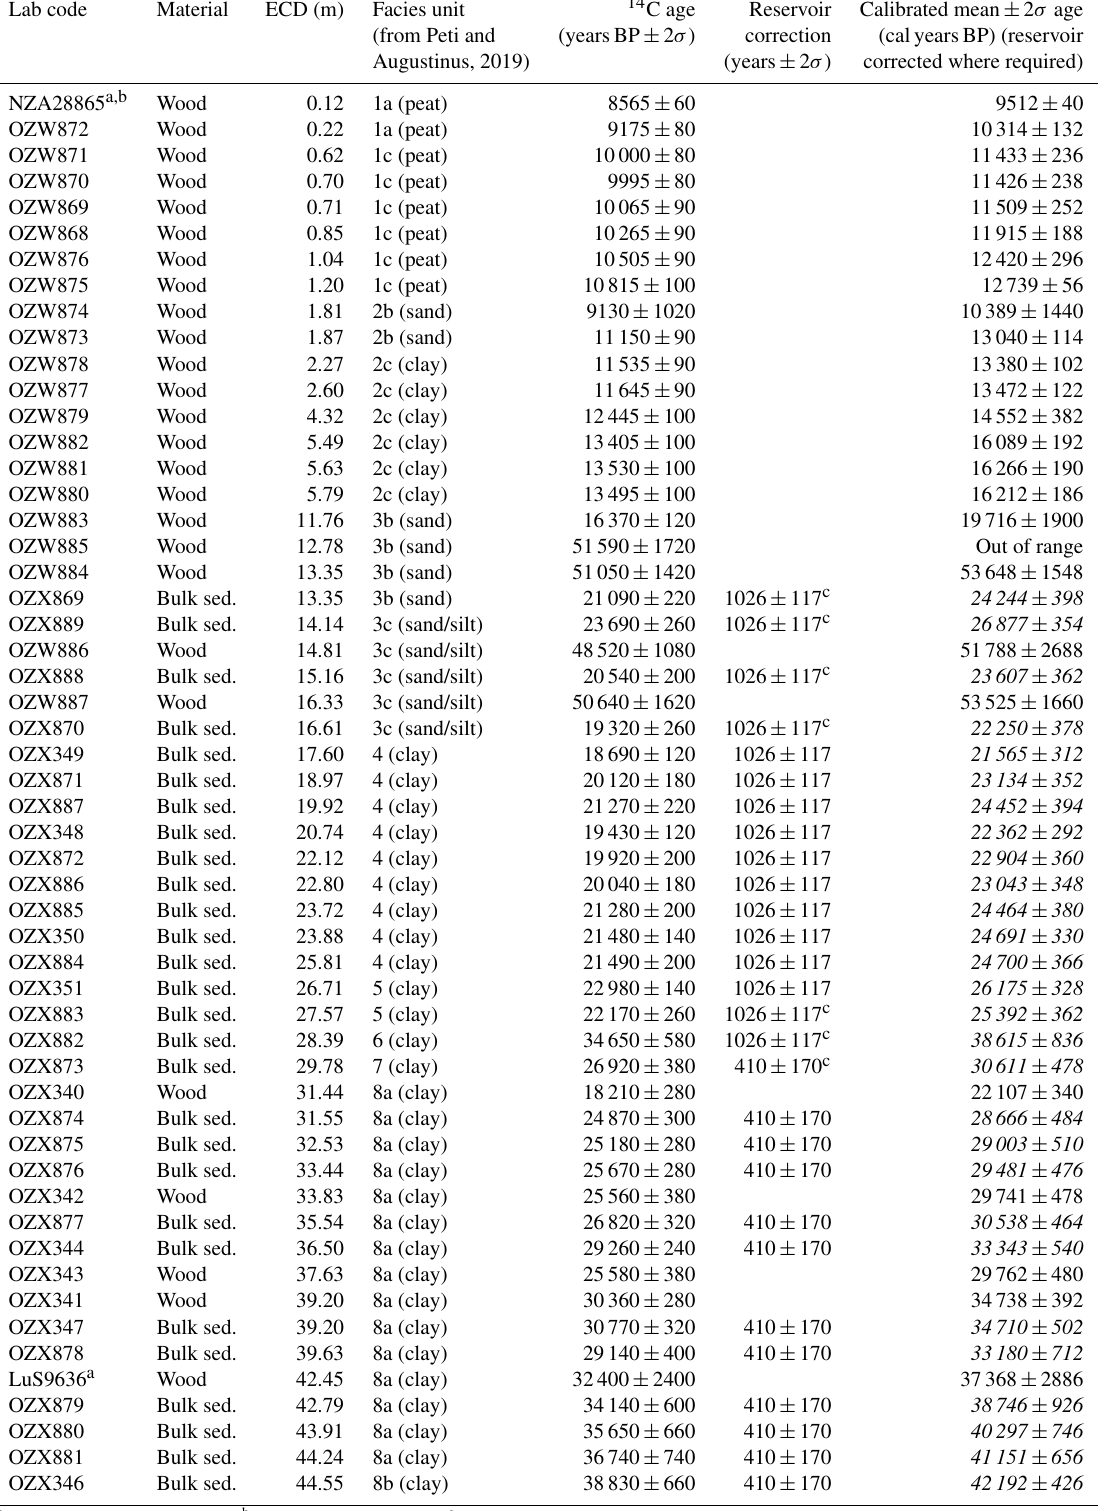
Table 3. Overview of radiocarbon samples and ages. Reservoir-corrected ages in italics. Outliers in grey. All are calibrated by SHCal20 (Hogg et al.,